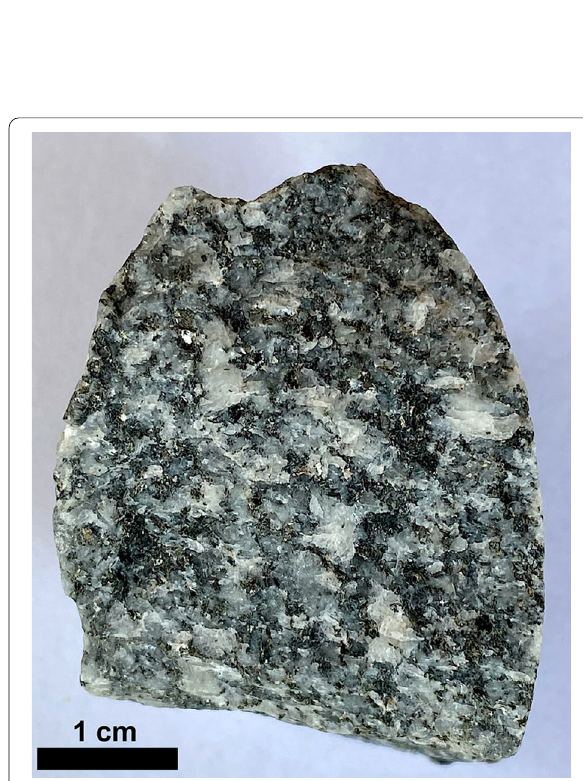
Fig. 8 Sample of quartz-monzodiorite, the predominant reservoir rock of the Basel-1 site at 4900 m depth; (width of sample ~ 3.5 cm). The coarse grained undeformed plutonic rock contains plagioclase, alkali feldspar, quartz, biotite, hornblende and accessories. Modal plagioclase ~ 55 vol.%, X An ~ 0.34 (rock composition given in Table 3)